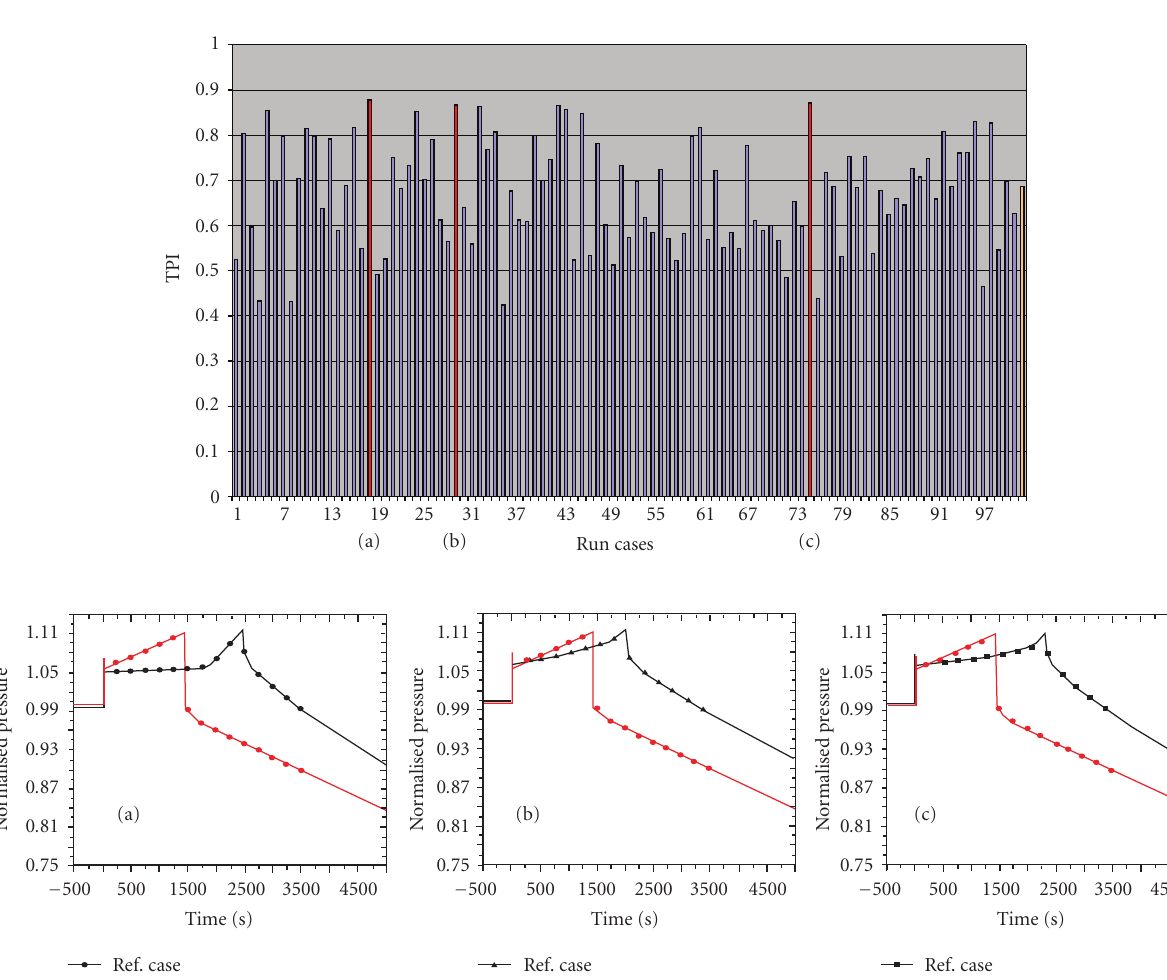
Figure 12: Sensitivity analysis to identify the worst system